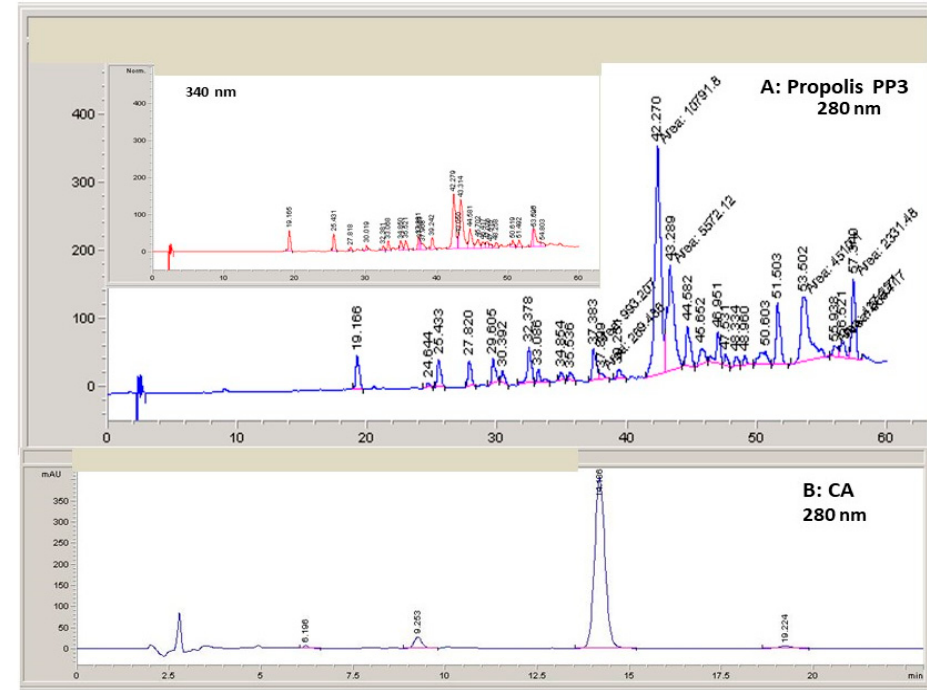
Figure 2. HPLC chromatographic profiles of propolis PP3 and CA monitored by absorbance at 280 nm ( A , B ) and 340 nm ( A insert). For details on the specific protocols followed for sample preparation and HPLC conditions, see Methods.